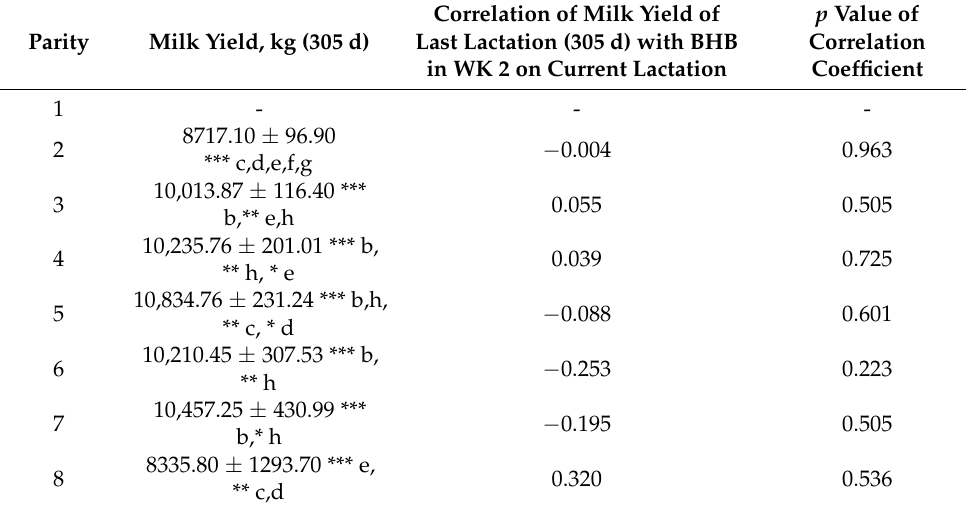
Table 2. The results of milk yield by parity and relationship of the last lactation milk yield with BHB concentration in WK 2. Parity Milk Yield, kg (305 d)